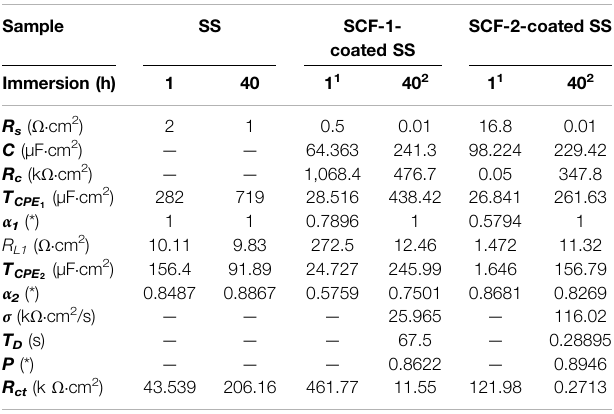
TABLE 3 | EIS Parameters obtained by the experimental data fi tting of the SS, SCF-1-coated SS, and SCF-2-coated SS samples, using Model 1 ( Figure 12A ), Model 2 ( Figure 12B ), and Model 3 ( Figure 12C